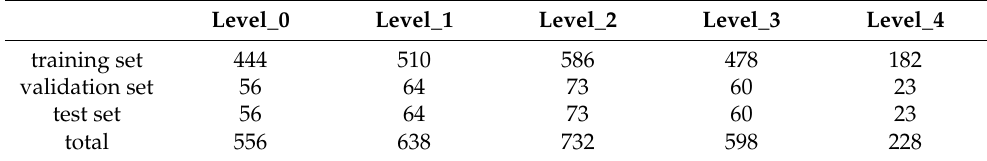
Table 1. The sample distribution in